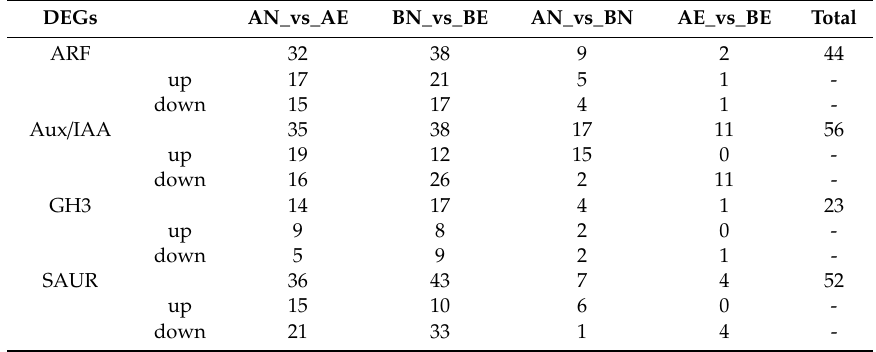
Figure 5. qRT-PCR analysis showing the expression of auxin early response ARF ( a ), Aux/IAA ( b ), GH3 ( c ), and SAUR ( d ) genes during transformation from NEC to EC. Callus samples from CCRI12